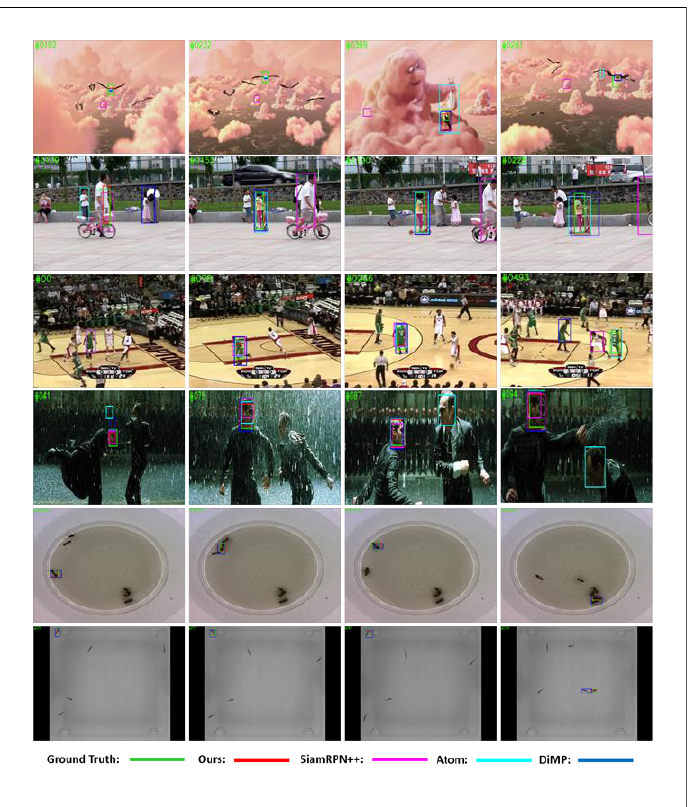
Figure 8. Visualization of our algorithm compared with other state-of-art